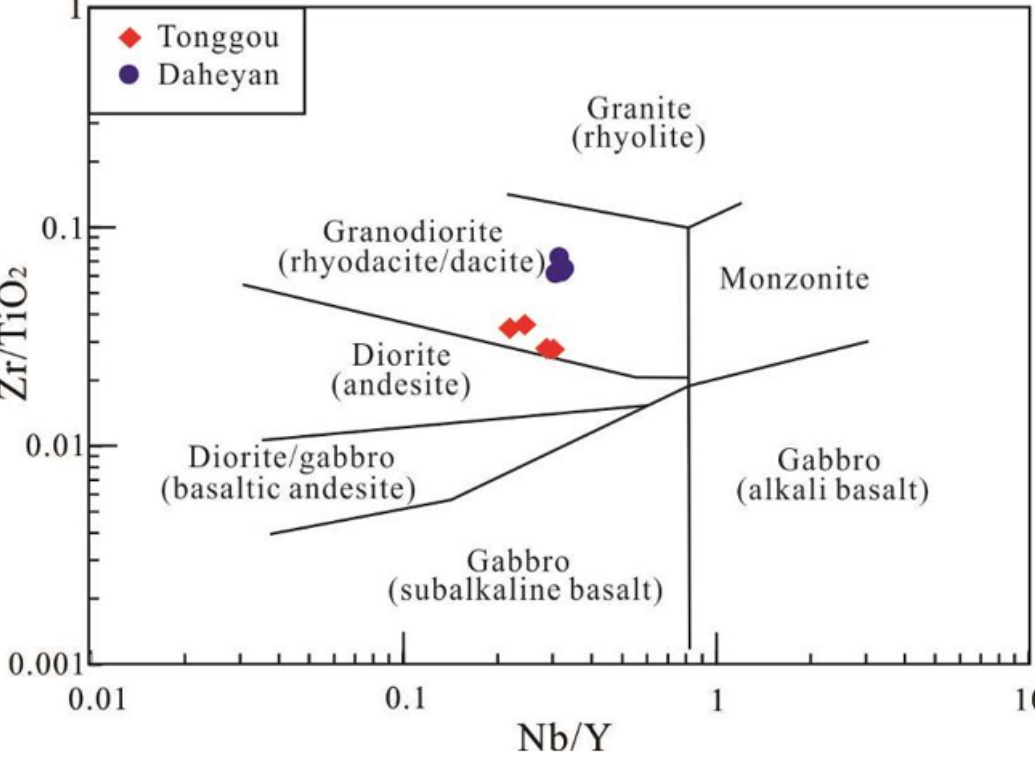
Figure 6. Zr / TiO 2 vs. Nb / Y of Tonggou and Daheyan samples following the classification in the literature [65,66]. Partial data for Daheyan granodiorite cited from [51]. TMG samples display a narrow range of Σ REE values (89.41–102.06 ppm), LREE values vary